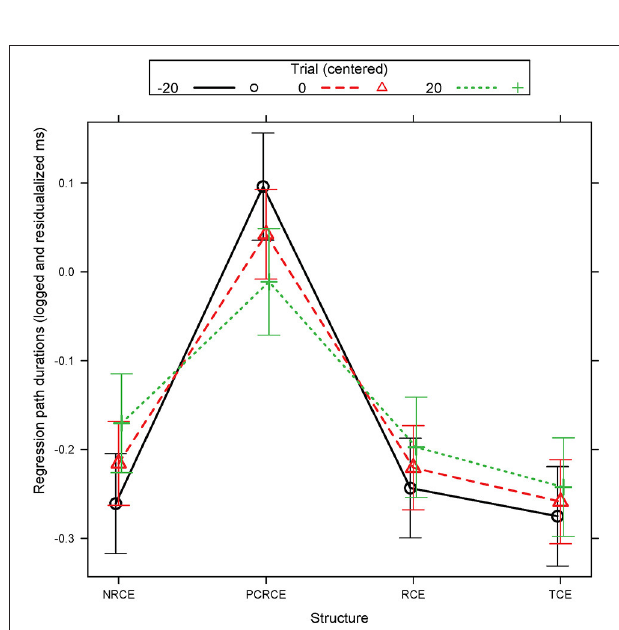
FIGURE 2 | Experiment 1 R01 estimated regression path durations (logged and residualalized ms): Structure by Trial interaction. Error bars represent the 95% confidence interval (CI) of the mean.